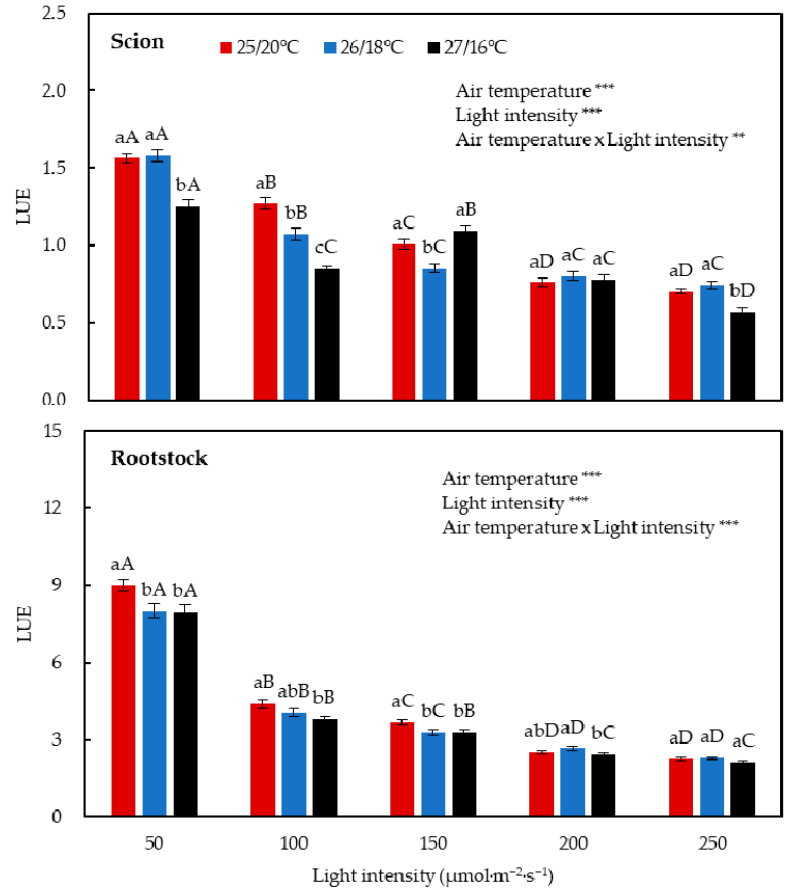
Figure 7. Light use efficiency (LUE) of cucumber scions and rootstocks as affected by the different air temperature and light intensity treatments in a PFAL. The error bar indicates the standard error of the mean for 3 replicates with 7 samples. ** and *** indicate significant differences at p < 0.01 and 0.001, respectively. Values with different letters differ significantly at the 95% level according to Tukey’s HSD test. Lowercase letters compares air temperature treatments for each light intensity treatment. Uppercase letters compare light intensity treatments for each air temperature treatment.